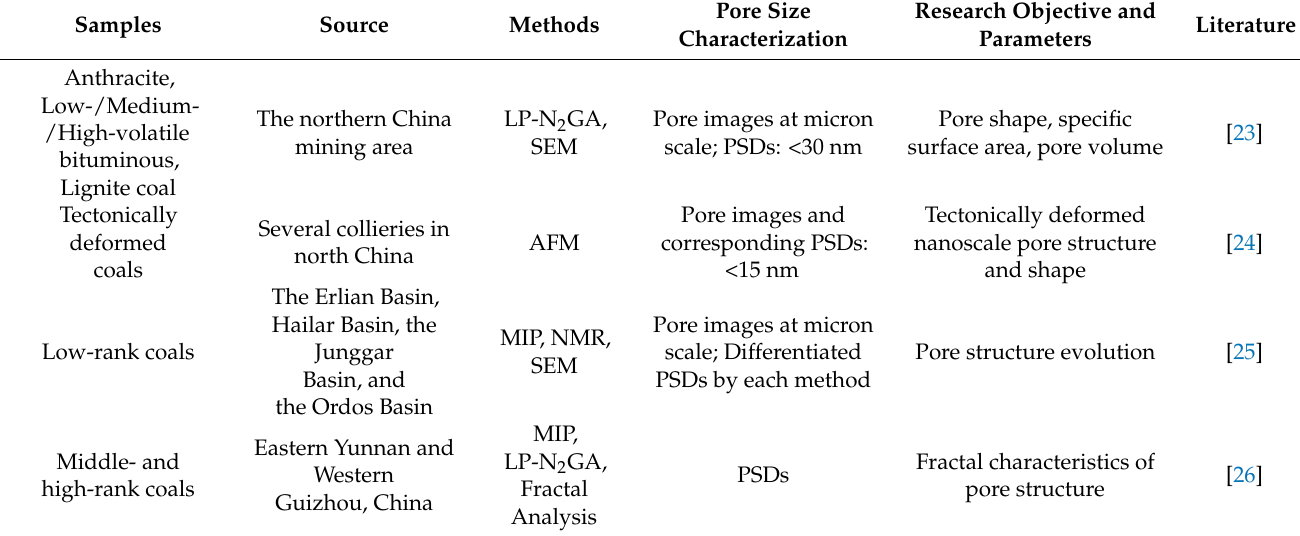
Table 1. Representative research progress on structure and classification research of coal pores in recent